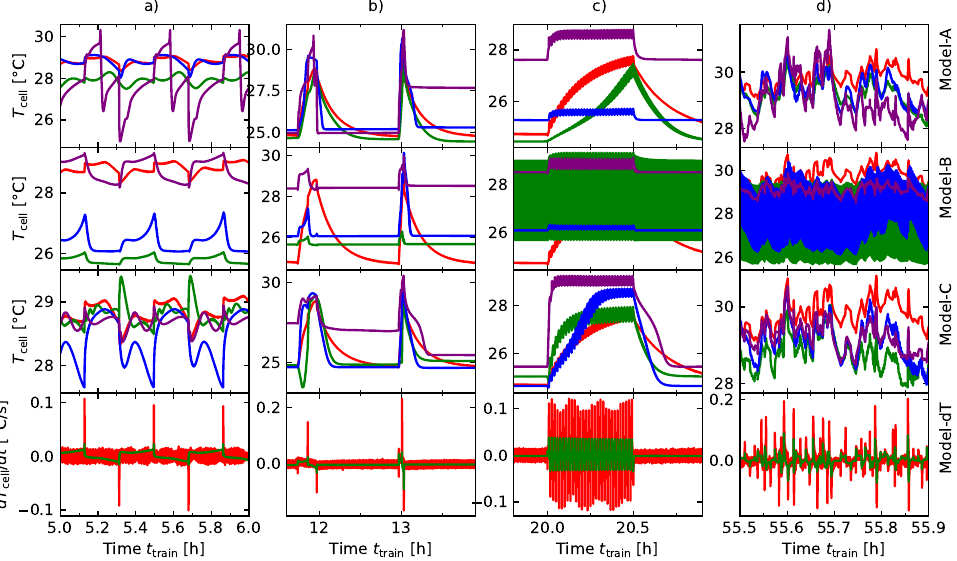
Figure 11. Predicted values of all models in four subfigures are given for the training data set. Model-A to Model-C show ground truth, Bayesian #1, Bayesian #2 and the most promising individual results. Model-dT illustrates ground truth and the predicted values of the dT-Model. Four areas are marked from ( a – d